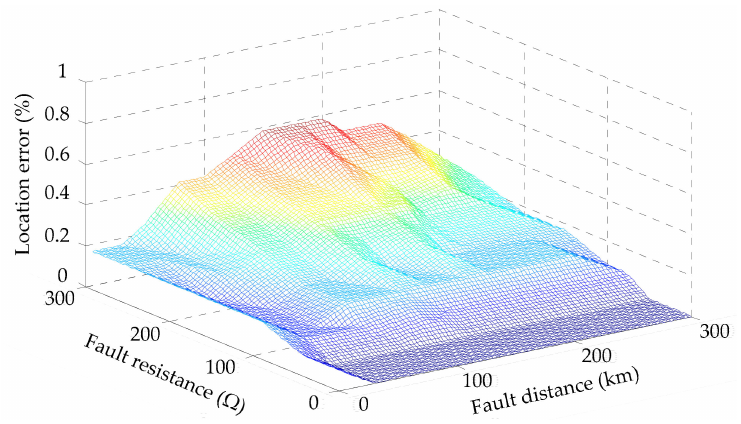
Figure 13. Location error with different resistances and different distances.